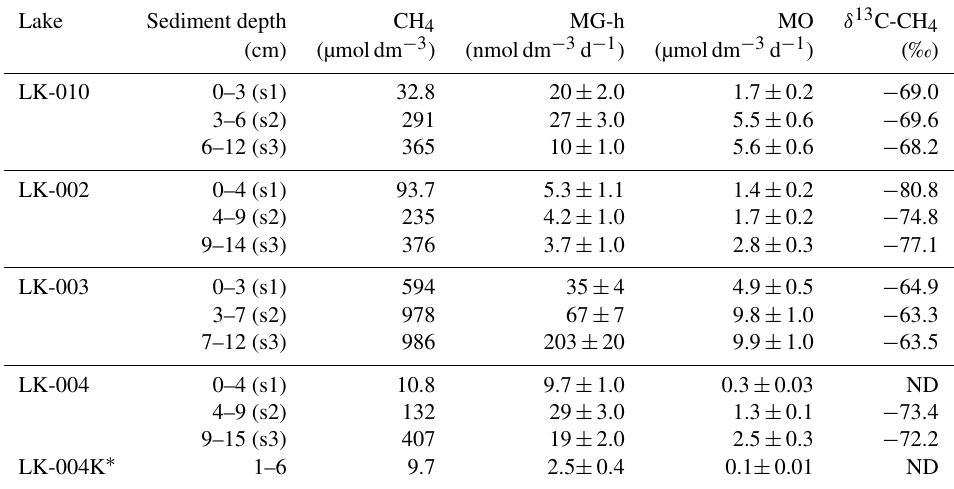
Table 3. Methane content, rates of hydrogenotrophic methanogenesis (MG-h) and methane oxidation (MO), and methane carbon isotope composition ( δ 13 C-CH 4 ‰) in the sediments of four Yamal tundra lakes.